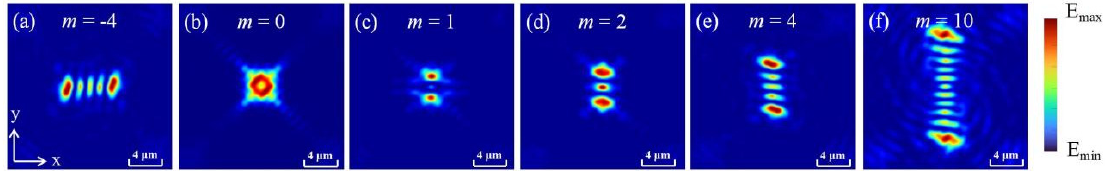
Figure 4. Schematic diagram of beam propagation with LOCP. The phase distribution ( a ) and the light field ( b ) diagrams of the XOY plane from z = − 20 μ m to z = − 60 μ m. ( c ) The optical field distri- bution diagram of the LOCP beam in the YOZ plane.